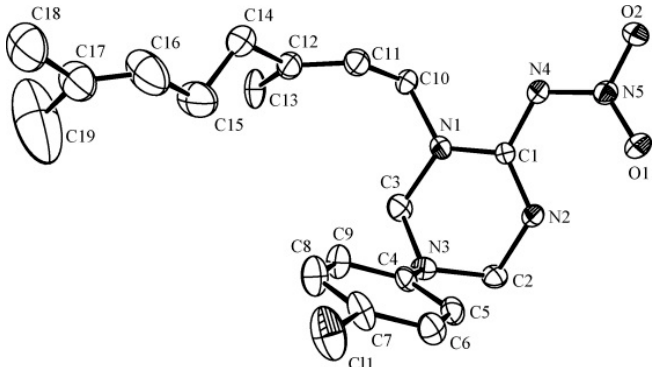
Figure 1. The crystal structure of the analogue 4r .